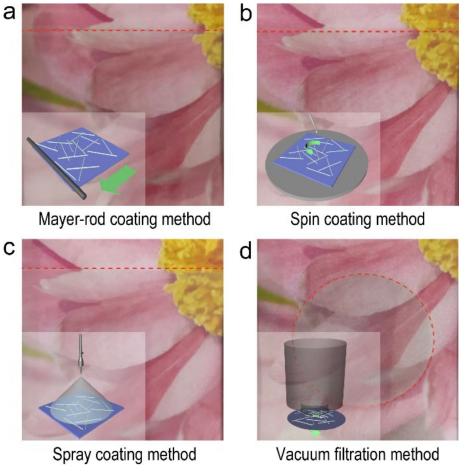
Figure 2. Photographs of Ag NW-based films prepared through ( a ) Mayer-rod coating, ( b ) spin coating, ( c ) spray coating, and ( d ) vacuum filtration methods. The inset is the corresponding diagrams of these four